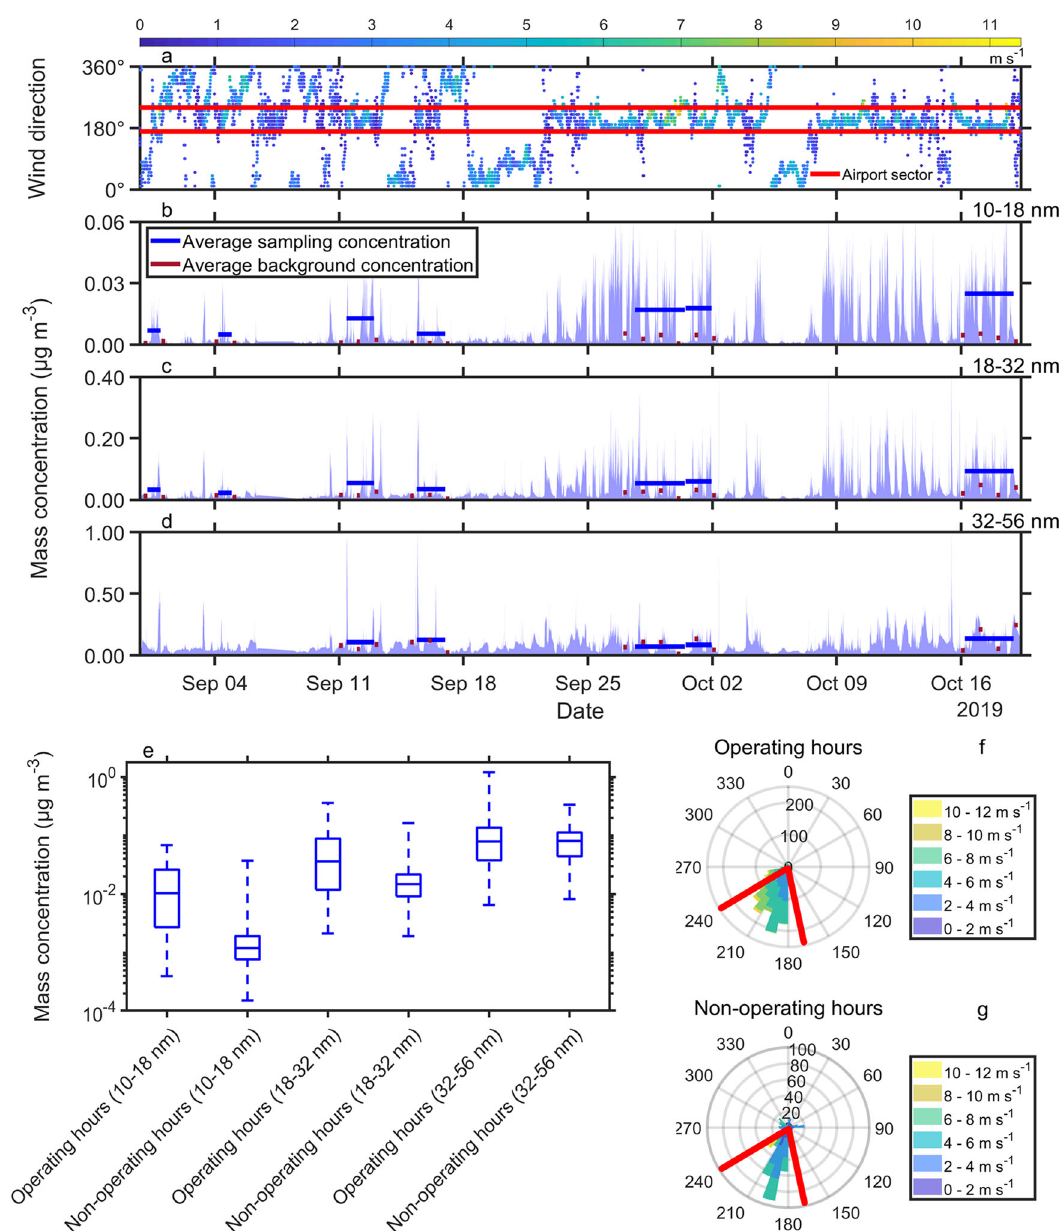
Fig. 2 Overview of the UFP mass concentrations derived from PNSD measurements and wind direction at Frankfurt Airport. Wind direction ( a ) with wind speed indicated by the colour code. The wind data is provided by the meteorological station at Frankfurt Airport (International Civil Aviation Organization, ICAO, code: EDDF) of the German weather service (DWD). The ambient UFP mass concentration ( µ g m -3 ) in the size ranges 10 – 18 nm ( b ), 18 – 32 nm ( c ) and 32 – 56 nm ( d ), and the Nano-MOUDI sampling intervals (horizontal lines), indicating the average mass concentration during sampling hours (blue) and the average background mass concentration (dark red). Boxplots in ( e ) show the spread of the total mass concentrations ( µ g m -3 ) for 10 – 18 nm, 18 – 32 nm and 32 – 56 nm particles during airport operating- and non-operating hours (based on SMPS data of the sampling- and background correction periods). The bottom and top of the boxes indicate the interquartile range and the horizontal line inside the boxes indicates the median. The whiskers show the scatter towards the most extreme values. The wind roses depict the prevailing wind directions during fi lter sampling at airport operating hours ( f ). Furthermore, the wind directions during the non-operating hour periods used for SMPS background correction are shown ( g